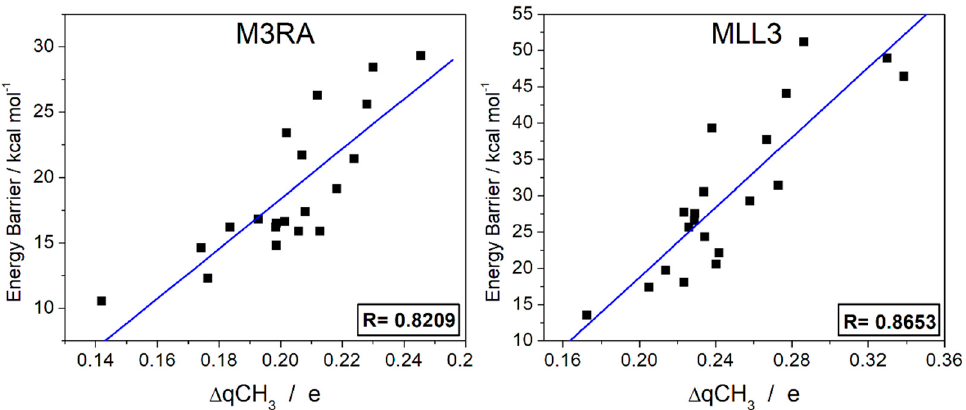
Figure 7. Plot of the charge transfer process taking place between the RS and the TS within the Met fragment during the methyl transfer process versus the energy barrier ( ∆ E ≠ ). The x-axis represents fragment during the methyl transfer process versus the energy barrier ( ∆ E (cid:54) = ). The x-axis represents the change in the charge of the transferred methyl group from R to the TS. the change in the charge of the transferred methyl group from R to the